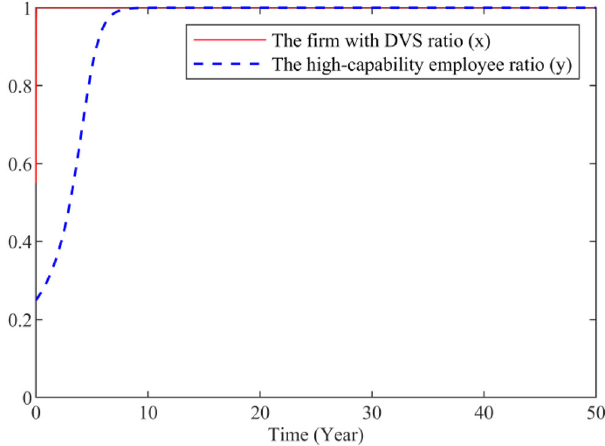
Fig. 6 Evolution of employees under DVS. There is an evolutionarily stable strategy with the mechanism of dynamic value sharing based on